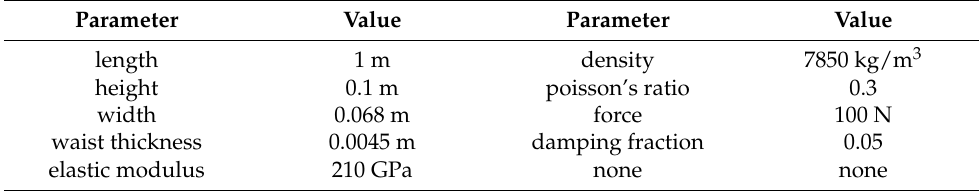
Figure 5. ( a ) Finite element model of a simple supported steel beam. ( b ) Shock time history and excitation position. Table 3. Basic parameters of the model.